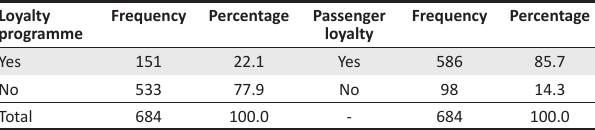
TABLE 5: Passenger loyalty statistics. TABLE 4: Loyalty programme and passenger loyalty.